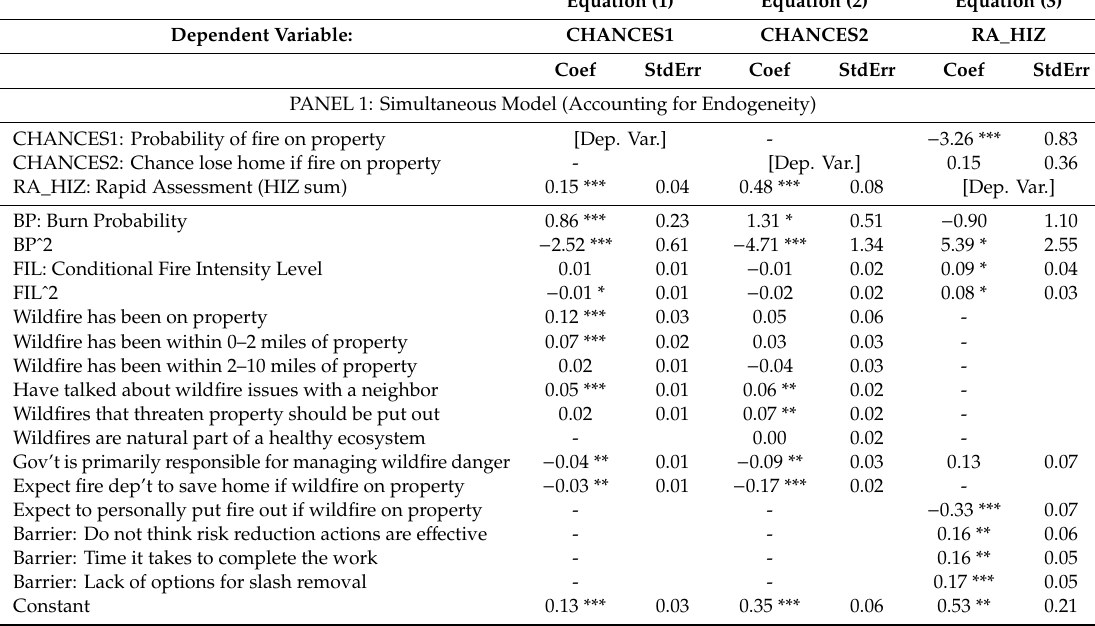
Table 4. Estimated coe ffi cients of separate and simultaneous regression models of survey respondents’ self-reported perception of likelihood of wildfire on their property (CHANCES1), likelihood of damage to their home if that occurs (CHANCES2), and the professionally assessed HIZ conditions (RA_HIZ). For all outcome variables, higher values correspond to higher risk. (n =